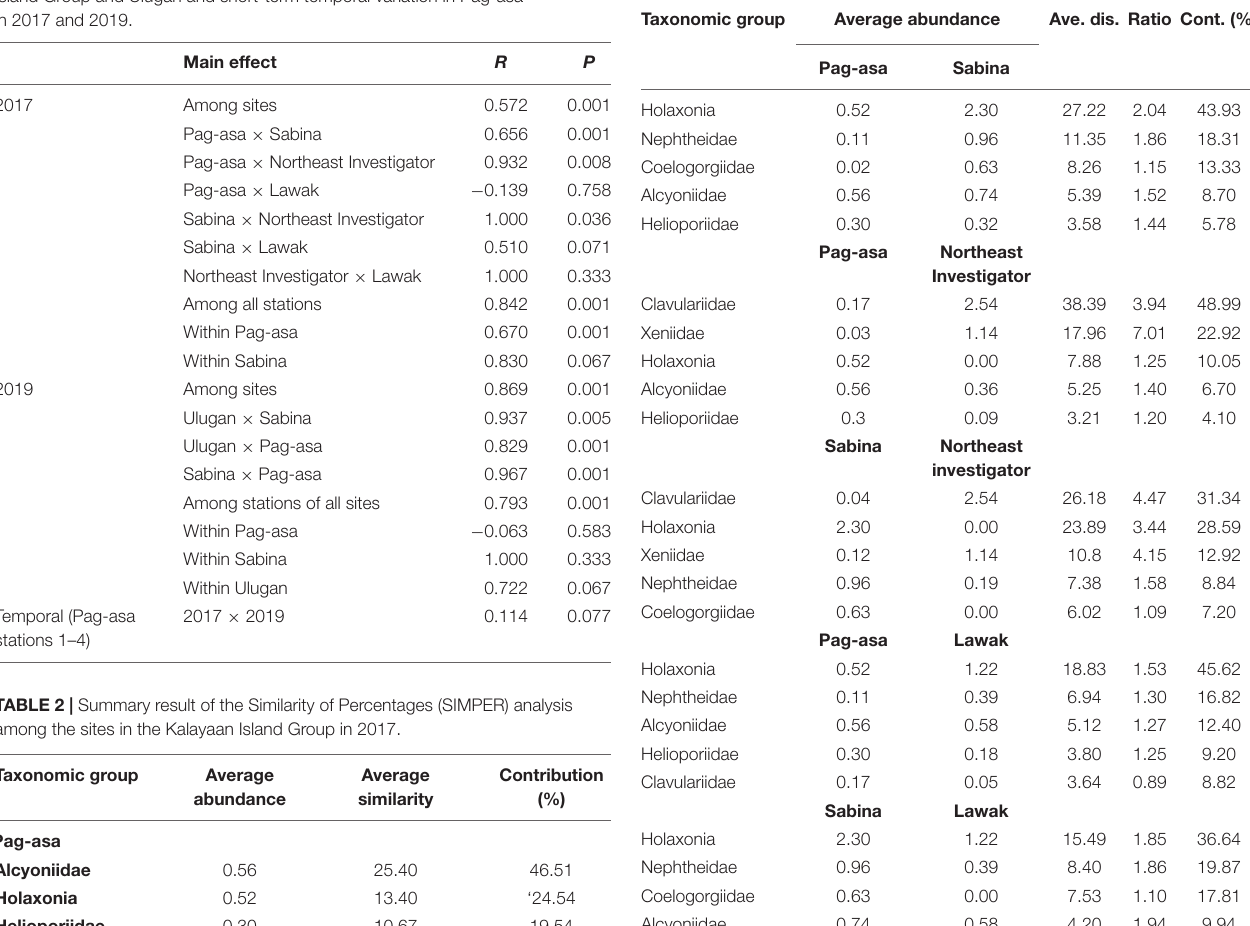
TABLE 1 | Summary result of the ANOSIM comparing octocoral assemblages at different spatial scales (among sites, stations and within site) in the Kalayaan Island Group and Ulugan and short-term temporal variation in Pag-asa in 2017 and 2019.